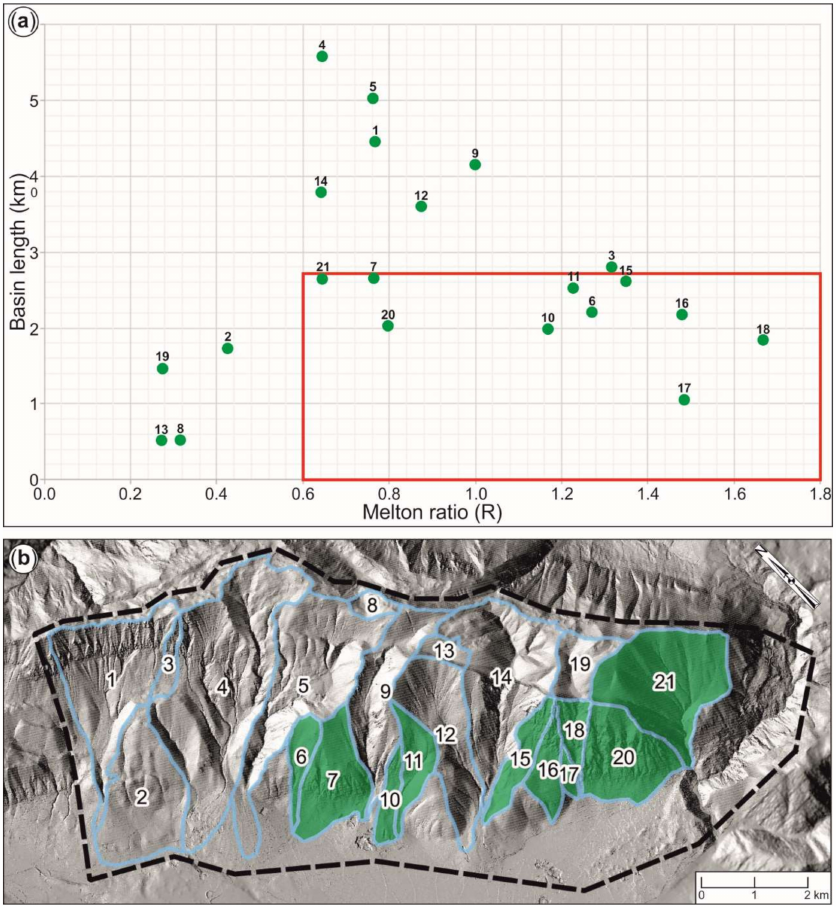
Figure 19. ( a ) Scatter diagram using the Melton ratio and basin length with class limits (red line) for the debris flow processes; ( b ) location map of the 21 basins. In blue the basin boundaries; in green basins prone to debris flow according to Wilford et al. [51]. The black dashed box indicates the location of the study